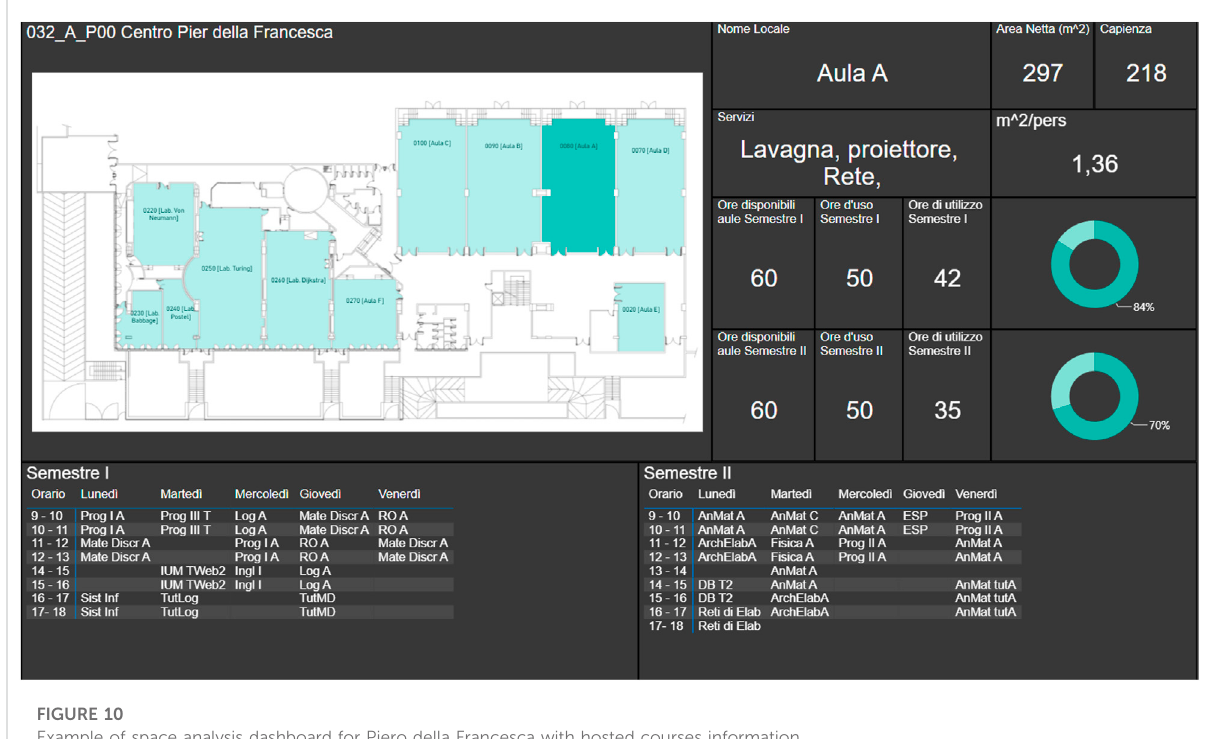
FIGURE 10 Example of space analysis dashboard for Piero della Francesca with hosted courses information.